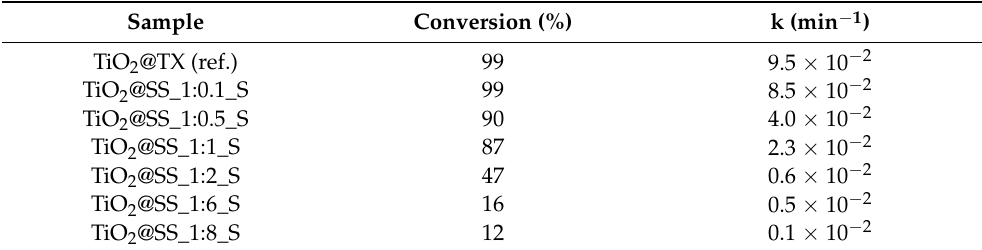
Table 3. Conversion (%) and kinetic constant (min − 1 ) obtained by photocatalytic tests of TiO 2 @SS_S samples synthesized via the sol–gel method.